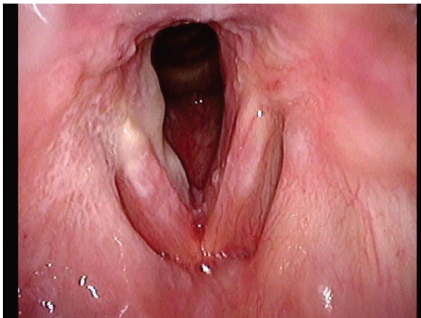
Figure 1: Laryngoscopy fndings at the initial examination showing elevated white lesions bilaterally on the vocal cords and subglottis.